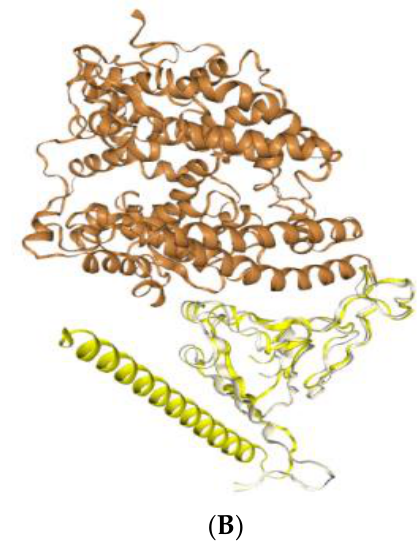
Figure 6. Docking result of the P1-pVIII fusion protein with the ACE2 receptor. The modeled struc- ture is available on the PDB database (PDB ID: 6M0J). ( A ) The structure of the SARS-CoV-2 spike receptor-binding domain (shown in gray) bound to ACE2 with PDB ID 6M0J (brown color). ( B ) Docking result of the Hdock server indicating the possible interaction of the 157 amino acid P1-pVIII fusion protein (shown in yellow) with the ACE2 receptor (docking score −205.4, RMSD: 36.8).